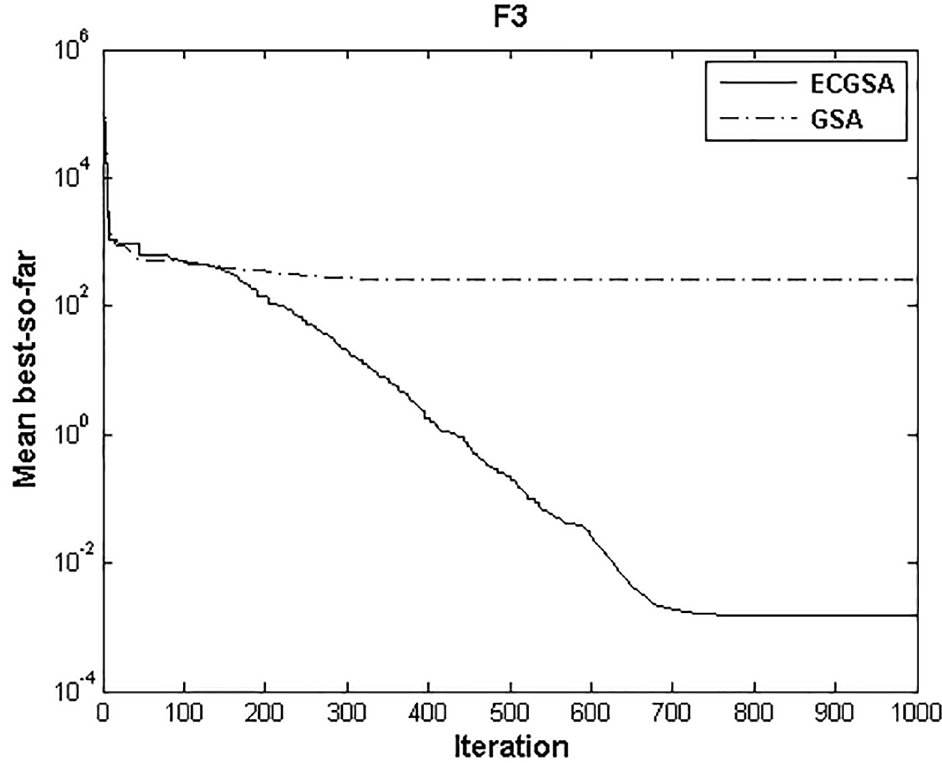
Fig 4. Performance comparison of ECGSA and GSA for F